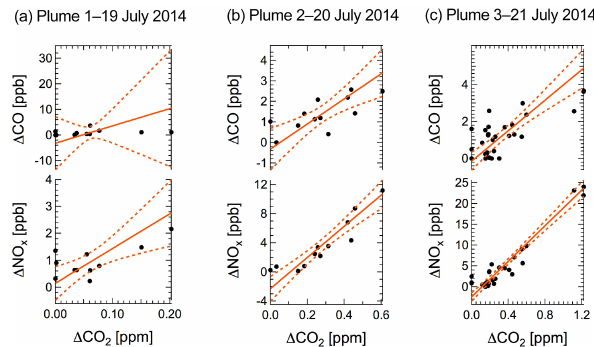
Figure 10. Scatter plot for excess gas pollutant mixing ratio vs. excess CO 2 for plumes 1 (a) , 2 (b) , and 3 (c) . Measurements are shown by black markers. The linear model fit is shown with solid red line, and the 90% confidence band for the linear model fit is shown with dashed red